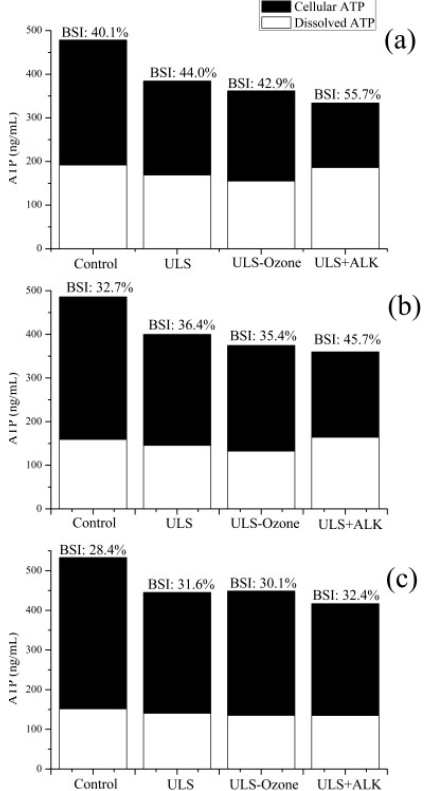
Figure 3. ATP distribution of each reactor at Condition I ( a ); Condition II ( b ); and Condition III ( c ).